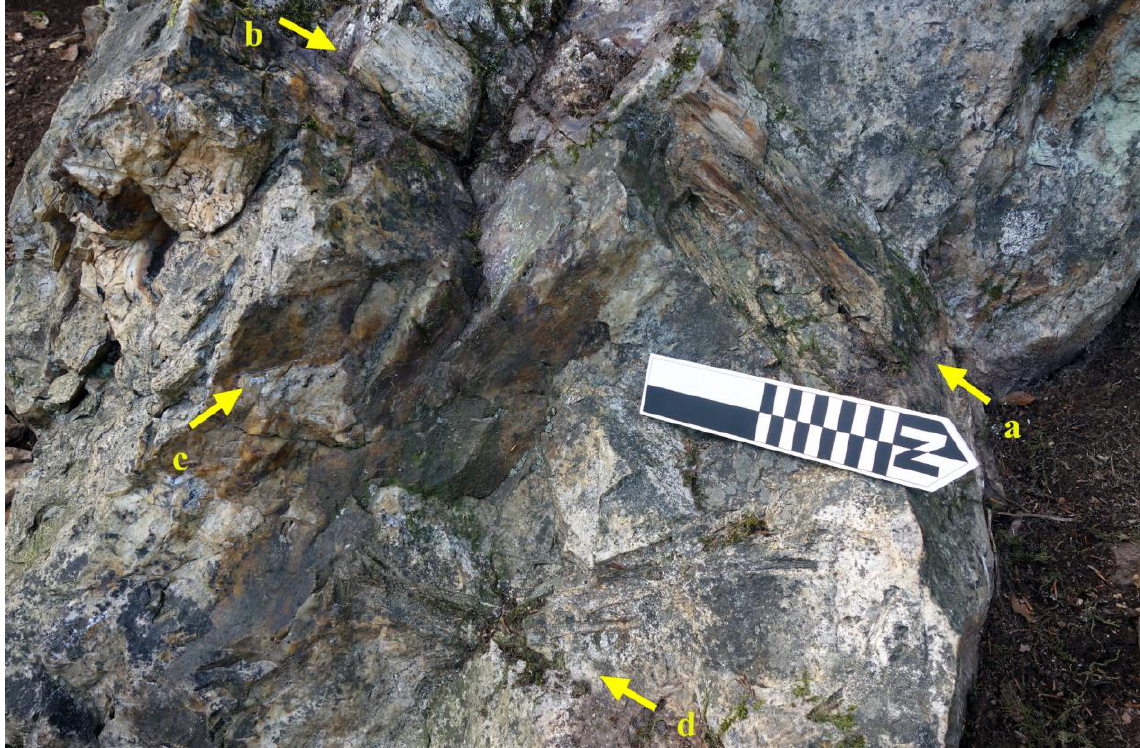
Figure 8. Lojanik 2, trench C: a) extracted tree branch; b) part of branch in situ; c) traces of the opal extraction process; d) negative of extracted part of tree. Scale in centimetres.